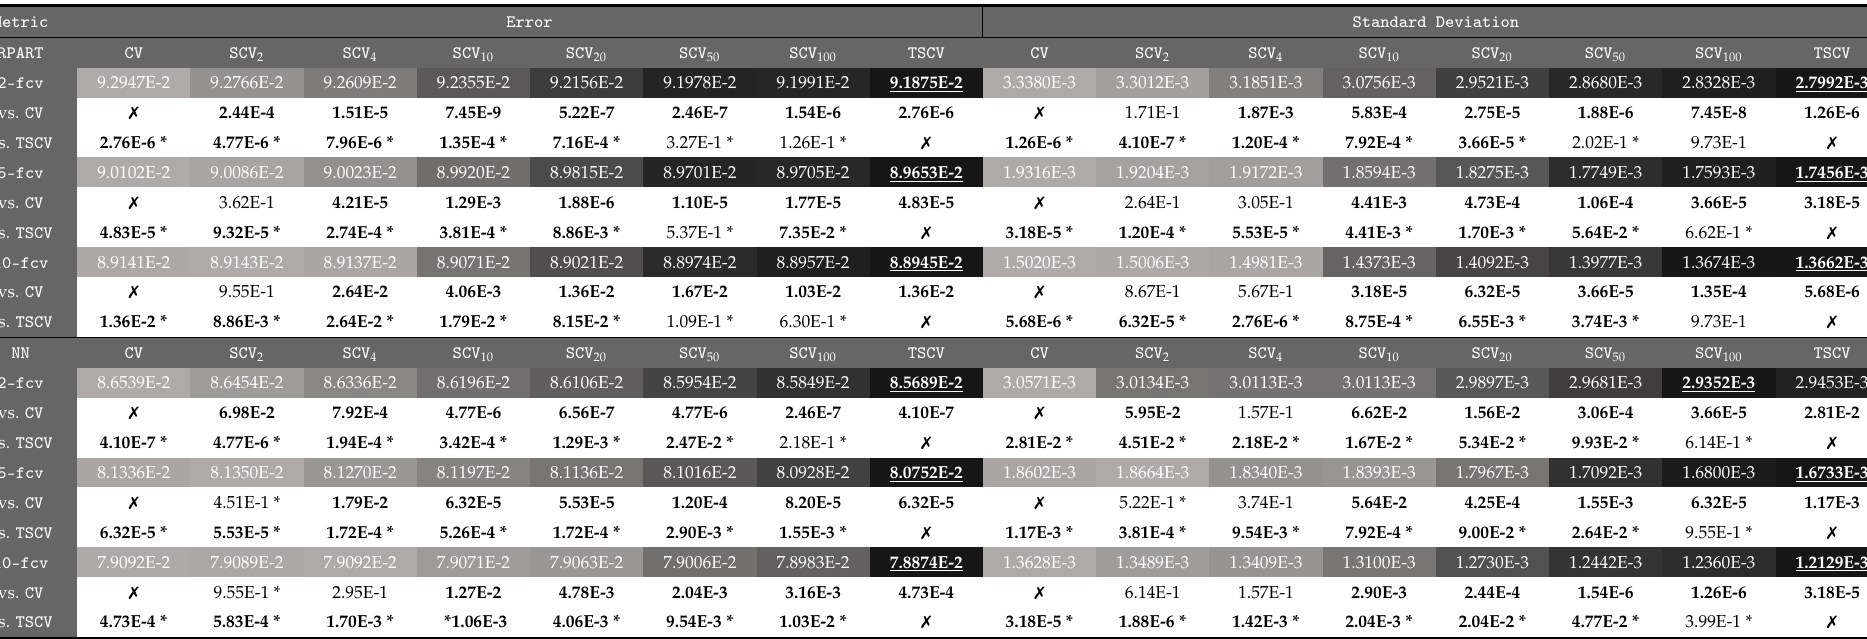
Table 5. Effect of stratification in error estimation ( RMSE ) and standard deviation results. A darker background in the results indicates that these are better. Those cases in which the method of the row obtains a higher sum of ranks than that of the column in Wilcoxon ’s test are indicated with an